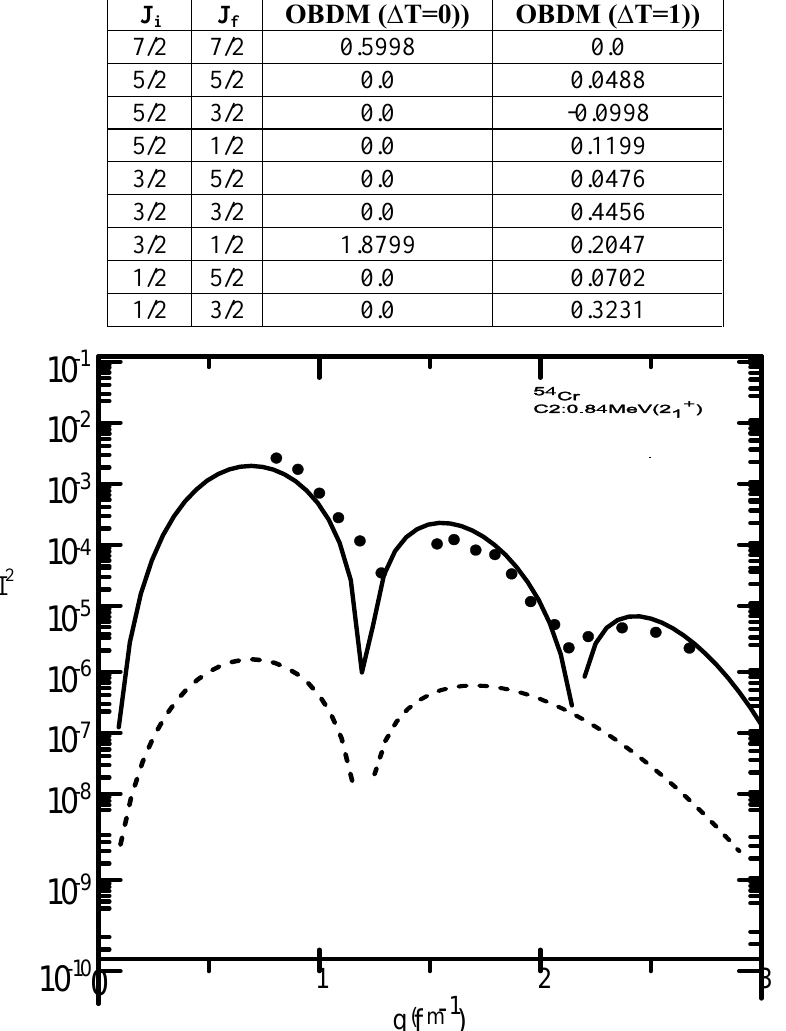
Table 4: The values of the OBDM elements for the longitudinal C2 Transition 2 + 3of 54 Cr.